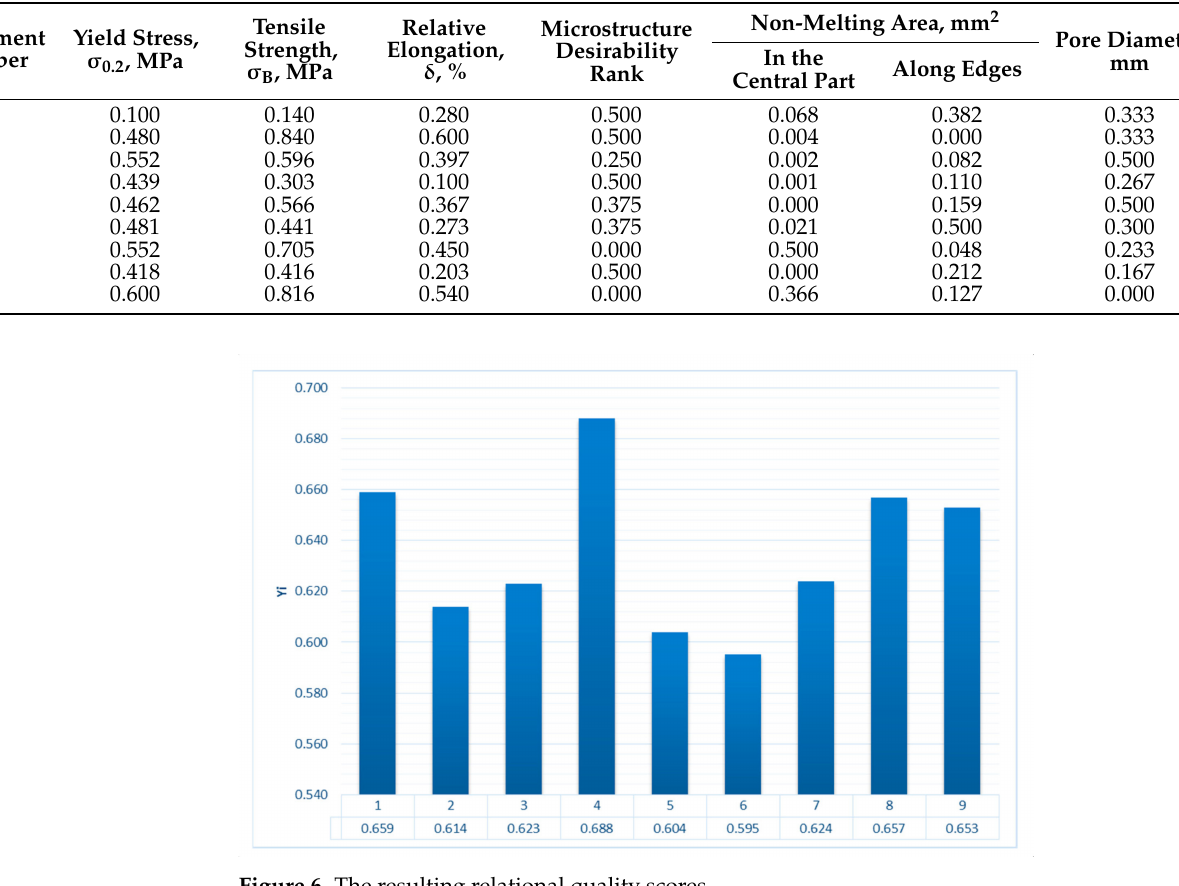
Figure 6. The resulting relational quality scores.